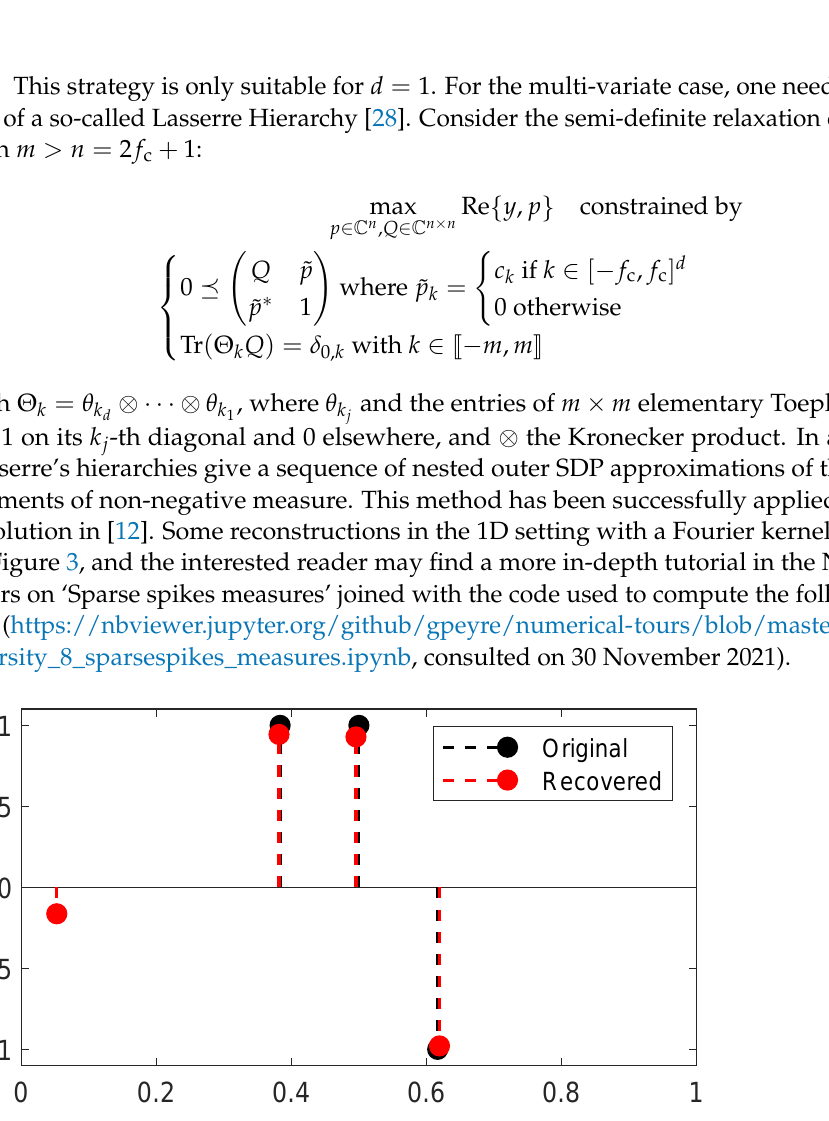
Figure 3. Reconstruction with the Interior Point Method for λ = 1. The algorithm detected a spurious spike near 0.05; otherwise, amplitudes and positions of the peaks are correctly